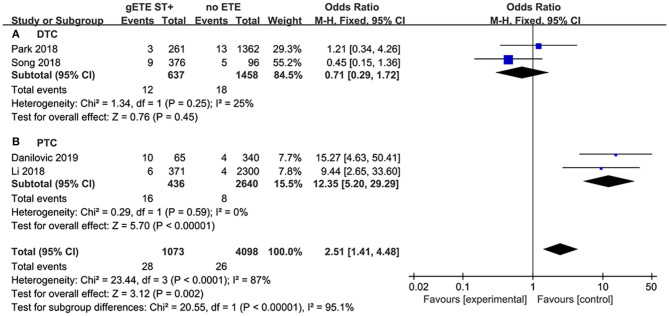
Subgroup analysis for DM comparison between gETE st+ with no ETE in DTC (A) and PTC (B).